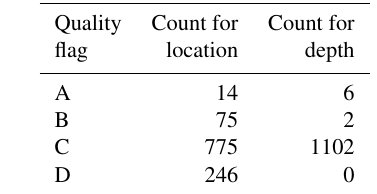
Table 4. Summary of the location and depth quality flags for the relocated extension events between 1904 and